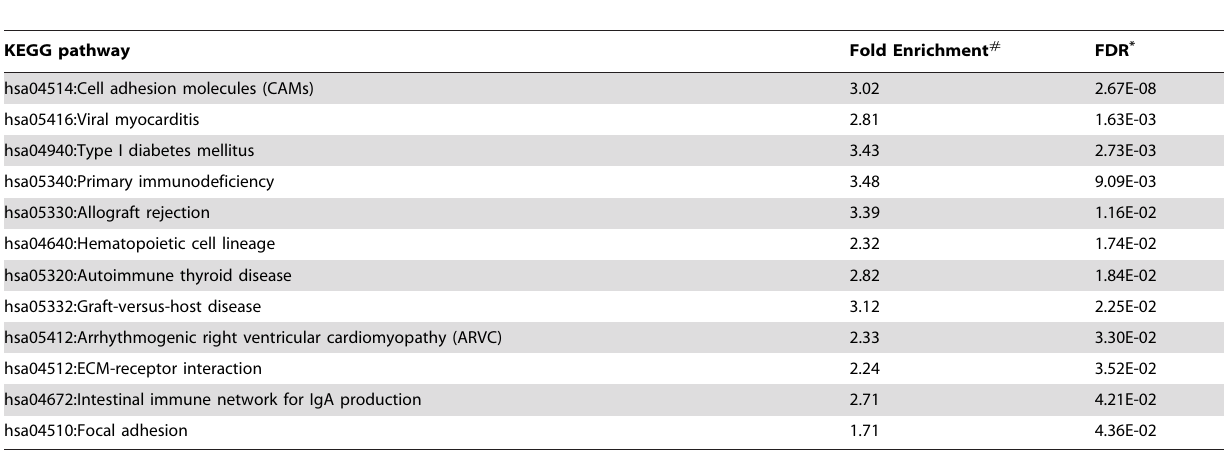
Table 3. KEGG pathways of enriched differentially expressed genes in bladder